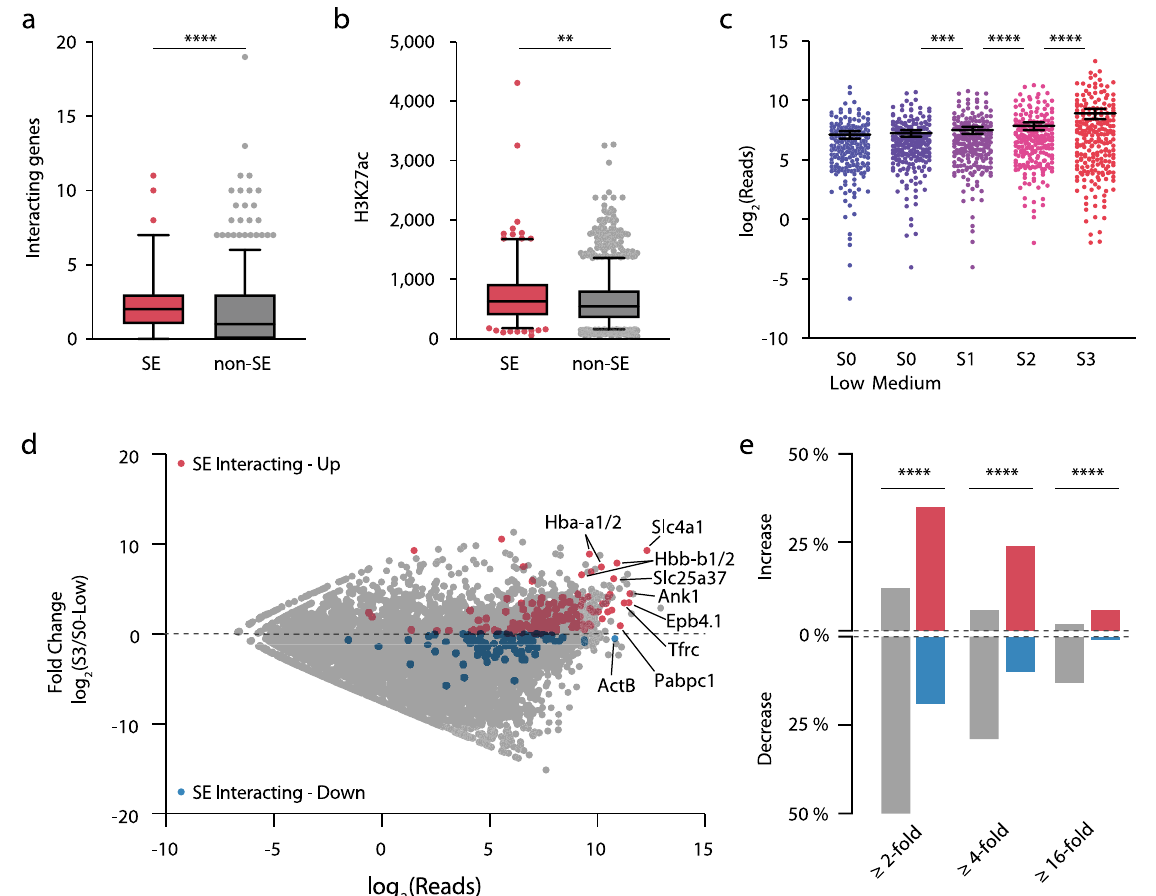
Fig. 7 Super-enhancers interact with a diverse set of genes. a Intersection of mature erythroid super-enhancers (SE, n = 95) and non-super-enhancers (non-SE, n = 1172) with signi fi cant interacting fragments (MPPC ≥ 0.01) identi fi ed interacting genes. b Level of H3K27ac (fragment per kilobase per million mapped reads) over the promoters of signi fi cantly interacting genes interacting with SE ( n = 226) and non-SE ( n = 2042). For a and b , boxplots whiskers show 5 – 95 percentile and box shows 25th and 75th percentiles with the median, ** p = 0.005, **** p < 0.0001 for a two-sided Mann – Whitney U -test. c Mean nascent expression for SE-interacting genes ( n = 226 genes, each dot is the mean of three biological replicates) throughout erythroid differentiation was determined using 4sU-seq in haematopoietic stem and progenitor and burst-forming unit-erythroid cells (S0-Low), early and late colony-forming unit-erythroid cells (S0-medium and S1, respectively), and maturing terminal differentiating cells (S2, S3). Error bars show mean with